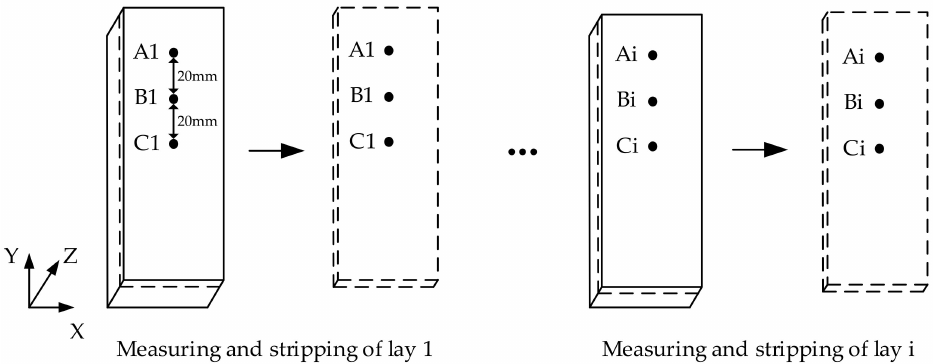
Figure 4. Measurement method and specimens with measuring